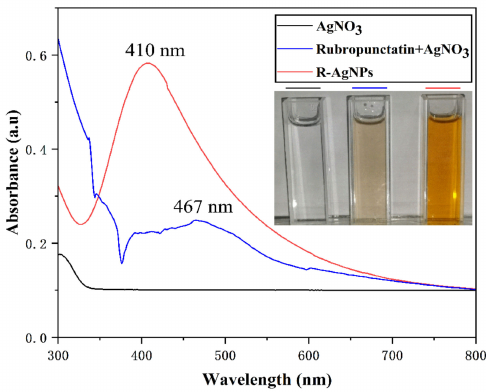
Figure 1. Image of the changing color of the reaction mixture before and after adding silver nitrate and UV–Vis spectrum of the R-AgNPs.